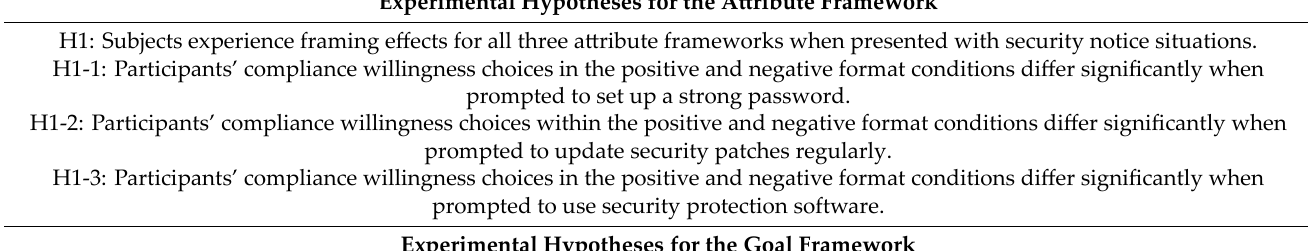
Table 1. Research Hypothesis. Experimental Hypotheses for the Attribute